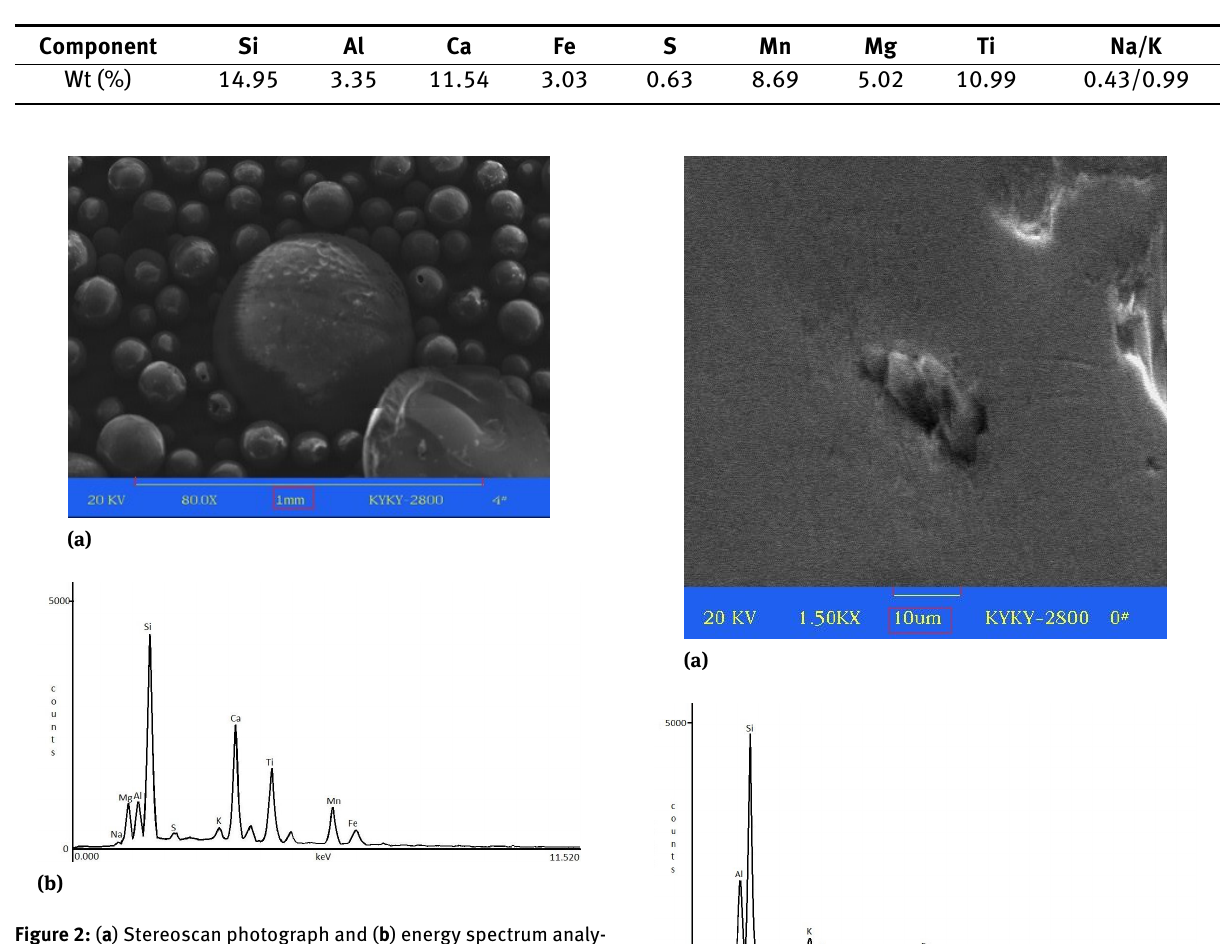
38.9%, and 27.8% of the total tested samples, respectively; all samples contained the K (or Na)